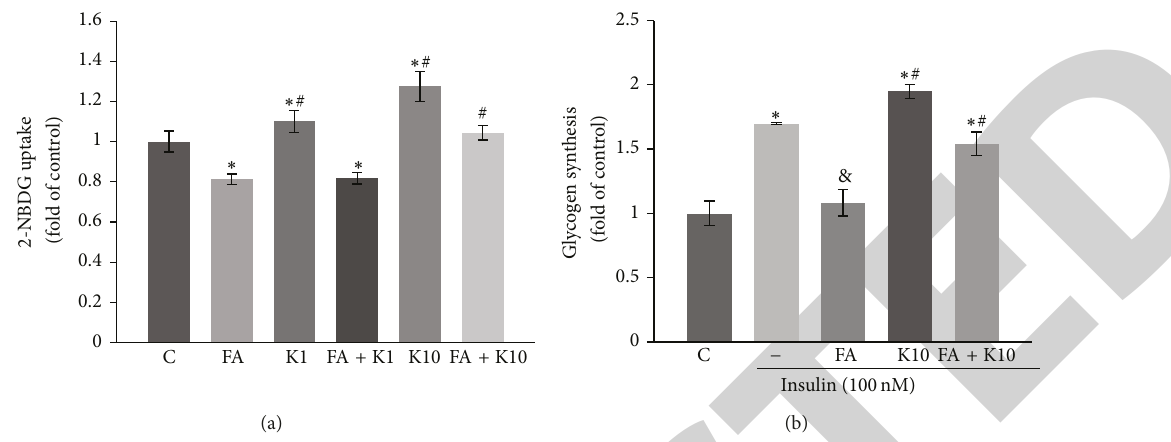
Figure 4: Kaempferol treatment reversed high fatty acid-impaired glucose uptake and glycogen synthesis in muscle cells. C2C12 myotubes were pretreated for 30 min with kaempferol (K1: 1 𝜇 M; K2: 10 𝜇 M) or DMSO followed by addition of 0.4 mM fatty acid mixture (FA: 2 :1 ratio of palmitate to oleate) or vehicle (C: BSA) as stated in Section 2. 24 h later, glucose uptake (a) and insulin-stimulated glycogen synthesis (b) were measured. Data are shown as means ± SEM ( 𝑛 = 4 ) of duplicate or triplicated determinations each. ∗ 𝑝 < 0.05 versus vehicle alone (C)-treated cells; & 𝑝 < 0.05 versus insulin alone-treated cells; # 𝑝 < 0.05 versus cells treated with FA and